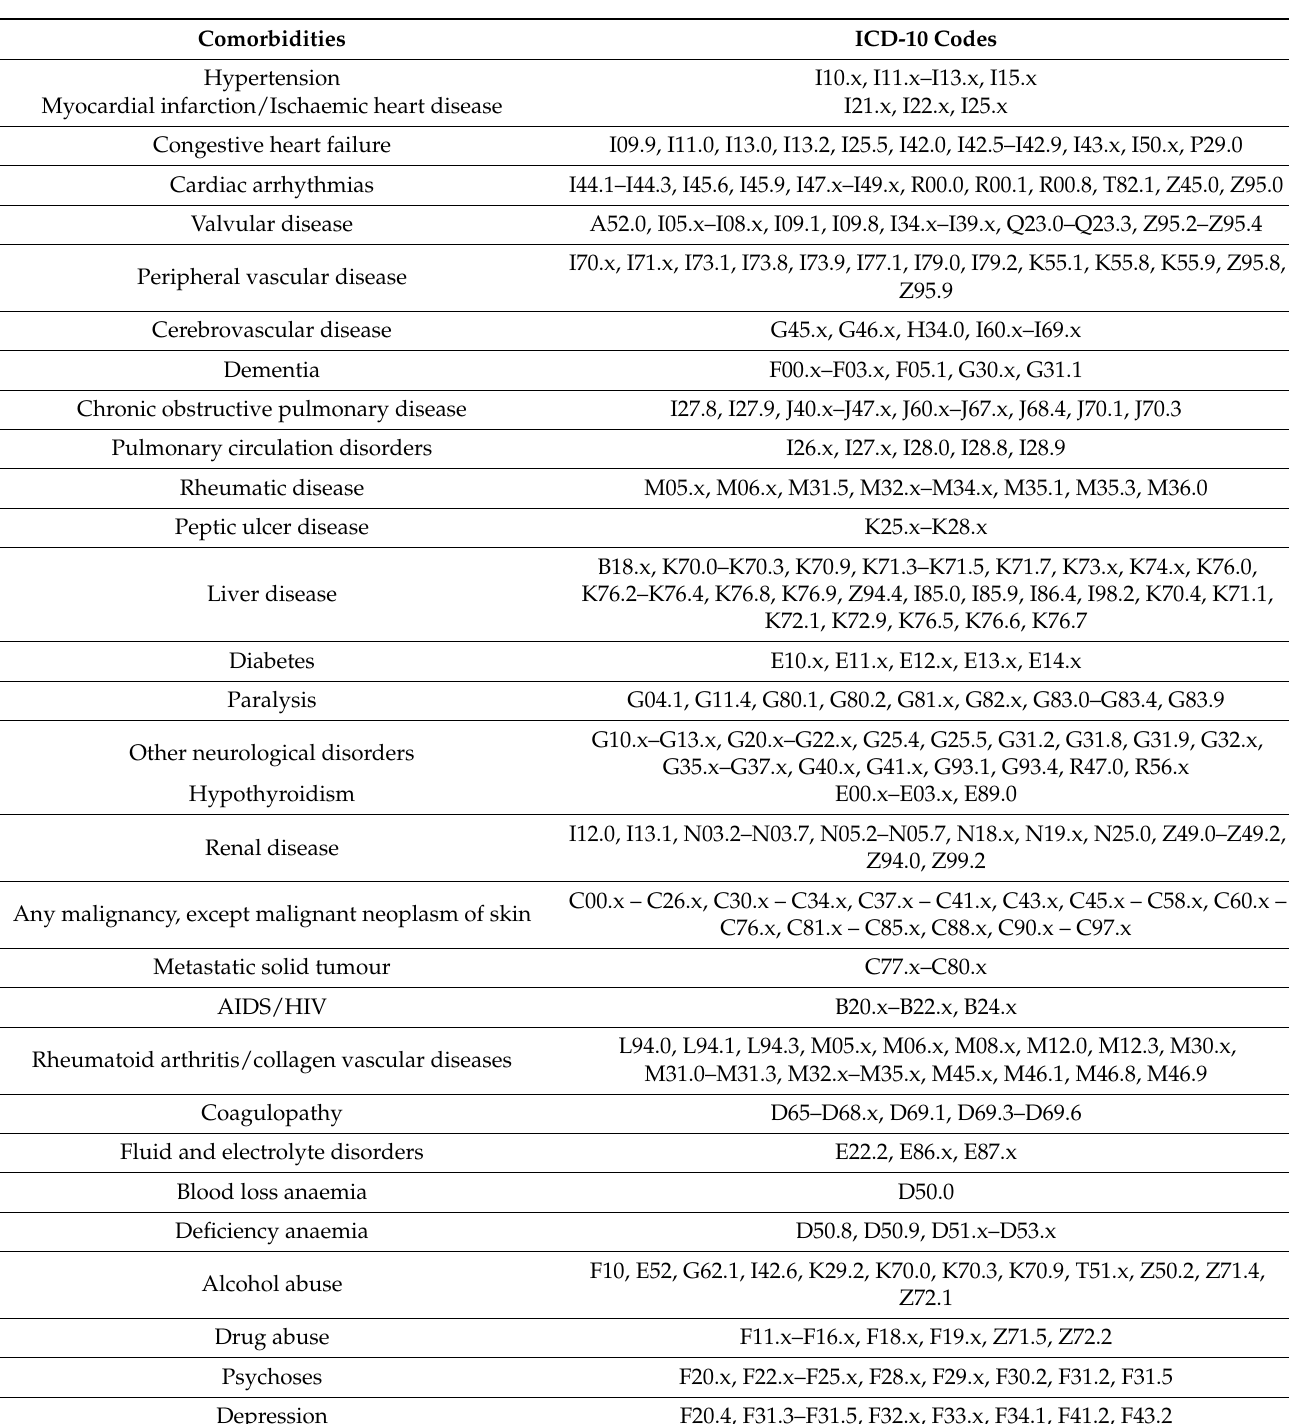
Table A1. ICD-10 codes of